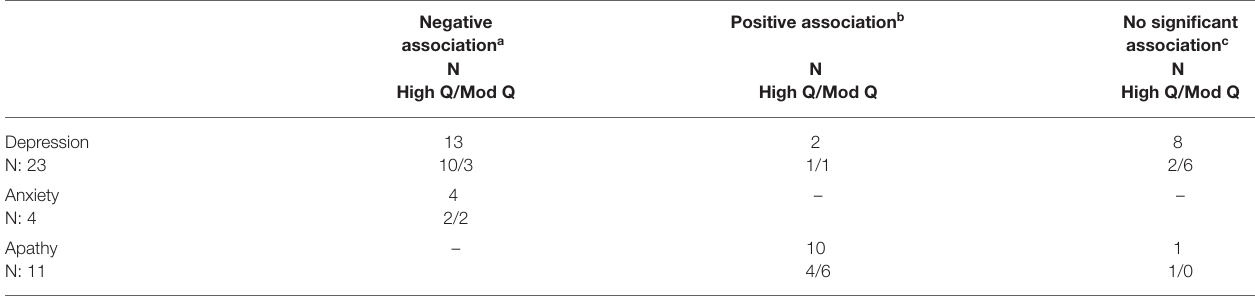
TABLE 3 | Association between impaired-awareness and depression, anxiety, and